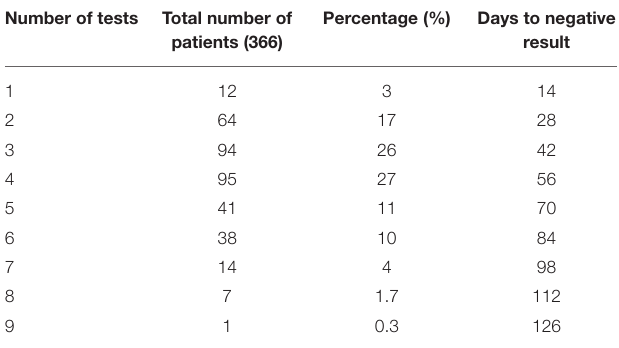
TABLE 3 | Days from the first SARS-CoV-2 positive diagnosis for institute workers until testing negative. Number of tests Total number of patients